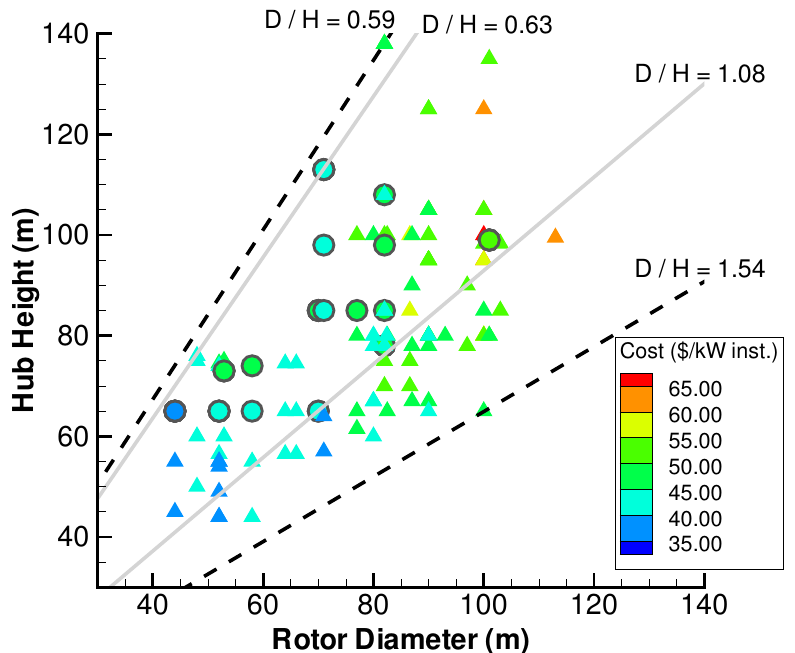
Figure 22. Rotor diameters and hub heights of the best tradeoff turbines (circles) and other available commercial turbines (triangles); grey lines enclose the D / H ratios of the best tradeoff turbines, and black dashed line encloses D / H ratios of all available